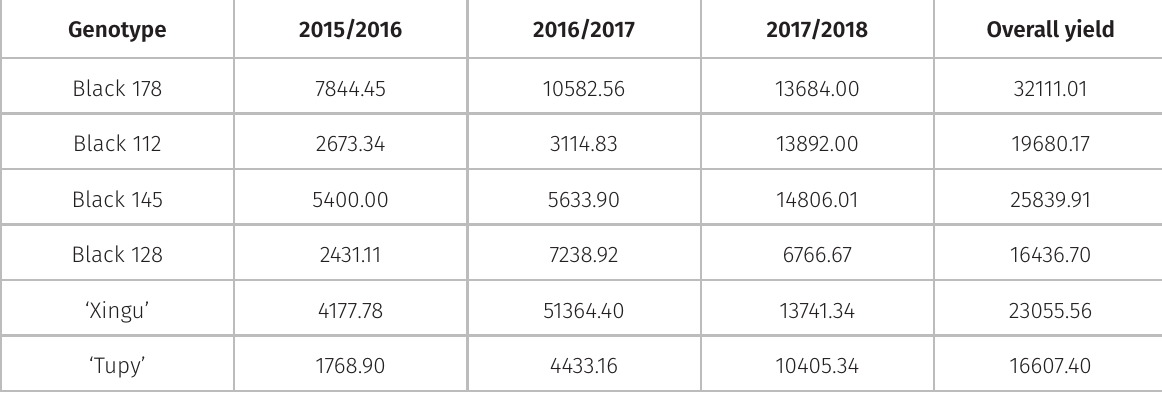
Table V. Overall yield, in kg.haˉ¹, of blackberry genotypes in an organic production system in 2015-16, 2016-17 and 2017-18 crops. Pelotas, RS, Brazil,